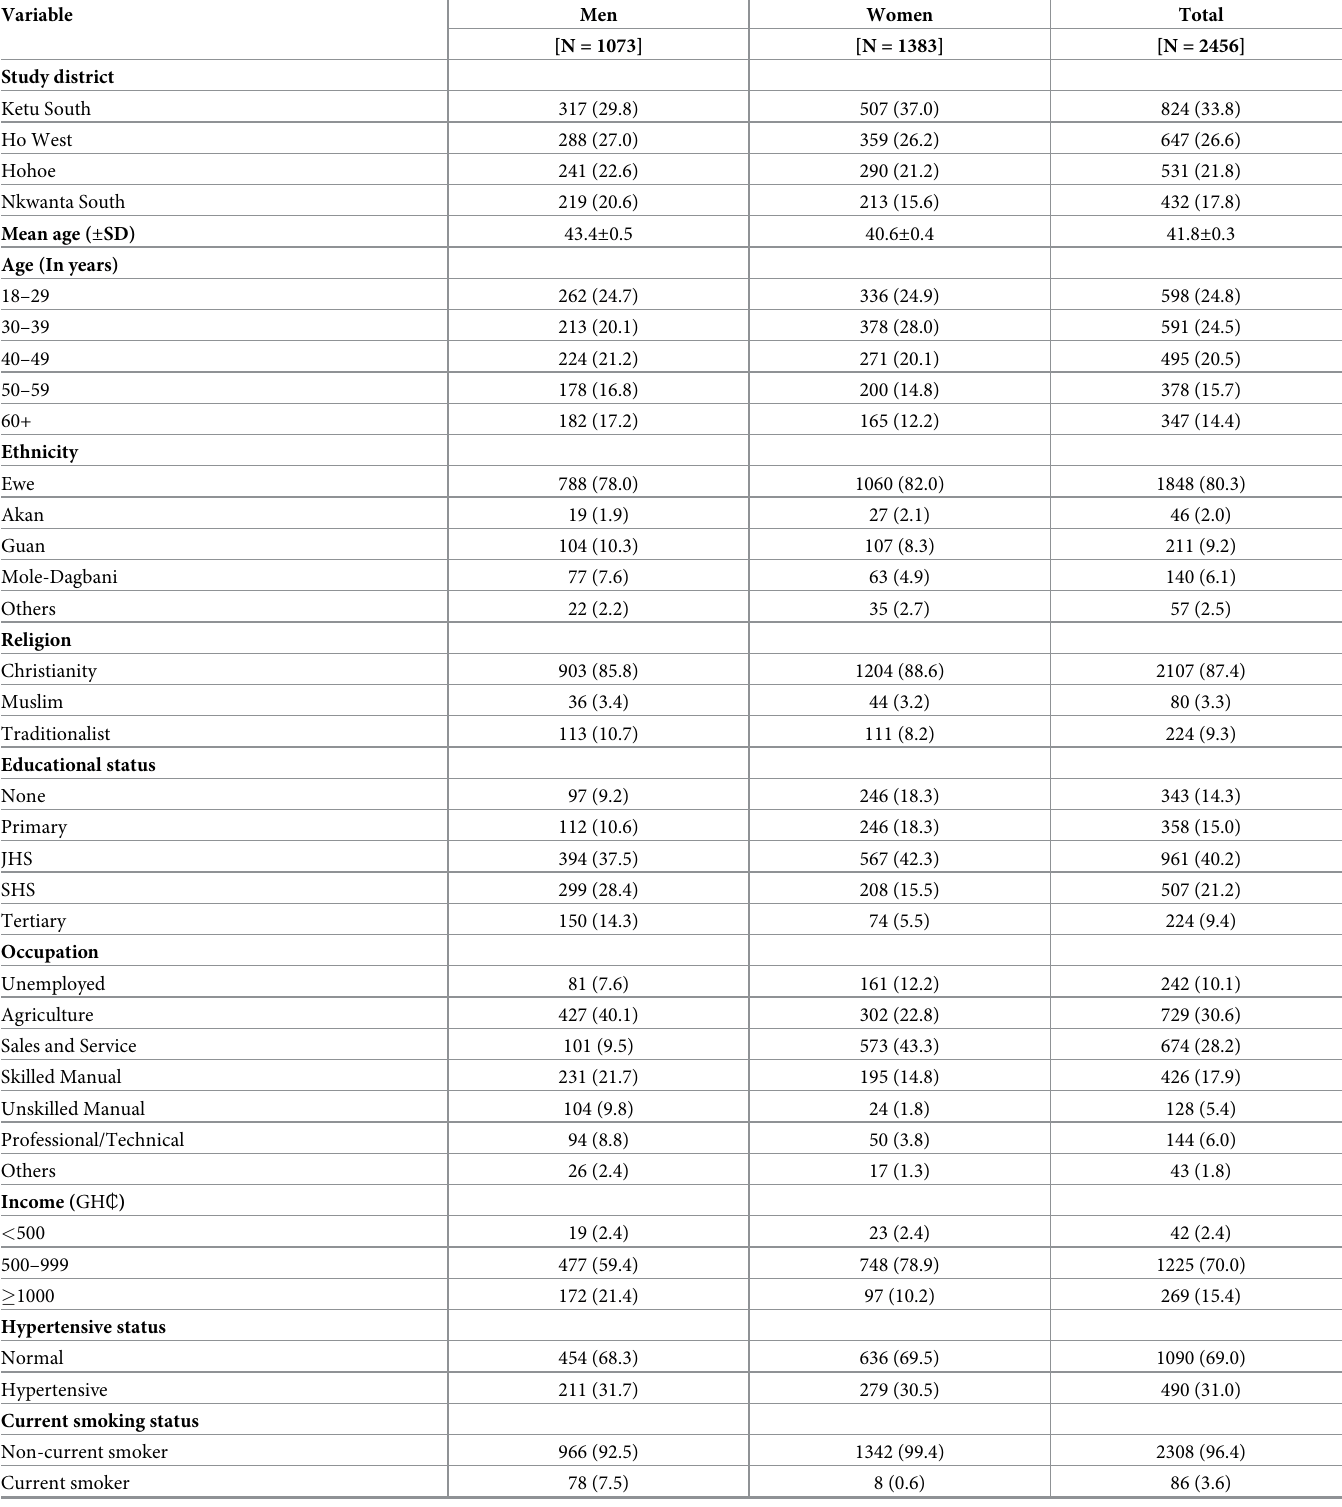
Table 1. Background characteristics of study